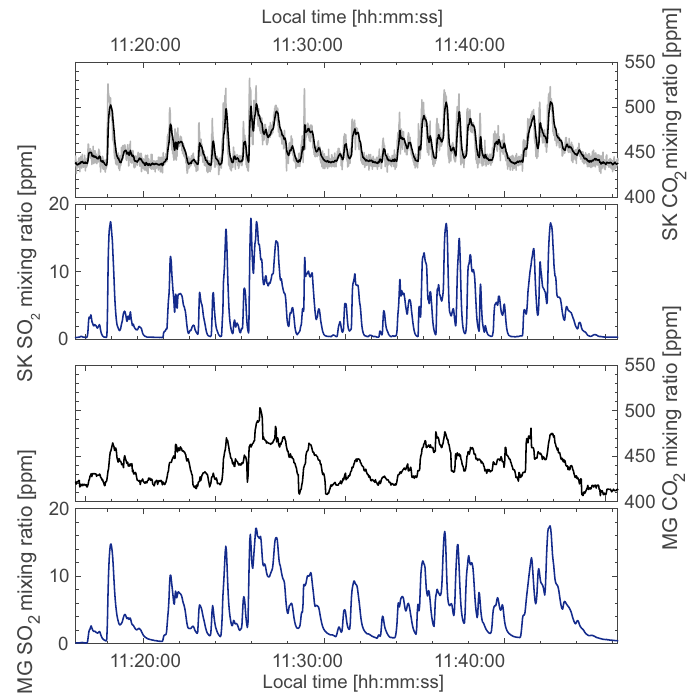
Figure 6. Comparison of SO 2 and CO 2 time series of a Multi-GAS (MG) instrument and the Sunkist (SK) unit at the Masaya volcano crater rim (for SK CO 2 raw data in grey, resampled data in black), both instrument inlets were placed in proximity to each other (14 July 2016); SK CO 2 / SO 2 = 3.63 ± 0.43 (background CO 2 = 439ppm); MG CO 2 / SO 2 = 2.94 ± 0.30 (background CO 2 = 413ppm); additional scatter plots in the